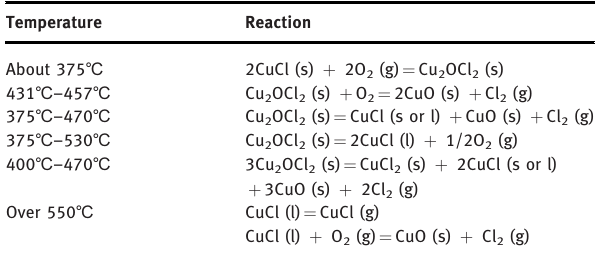
Table 2: The chemical elements of CuCl residue from zinc hydrometallurgy.